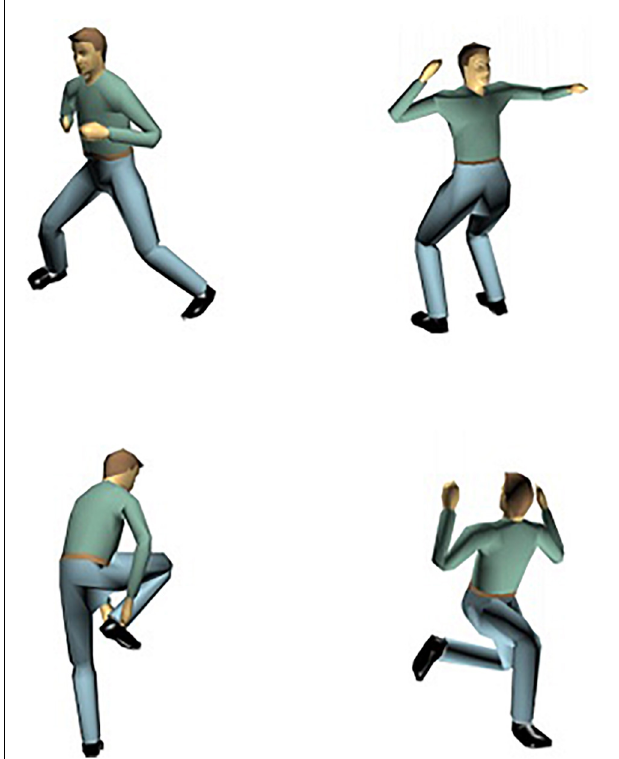
FIGURE 2 | Examples of anatomically possible (first column) and impossible (second column)